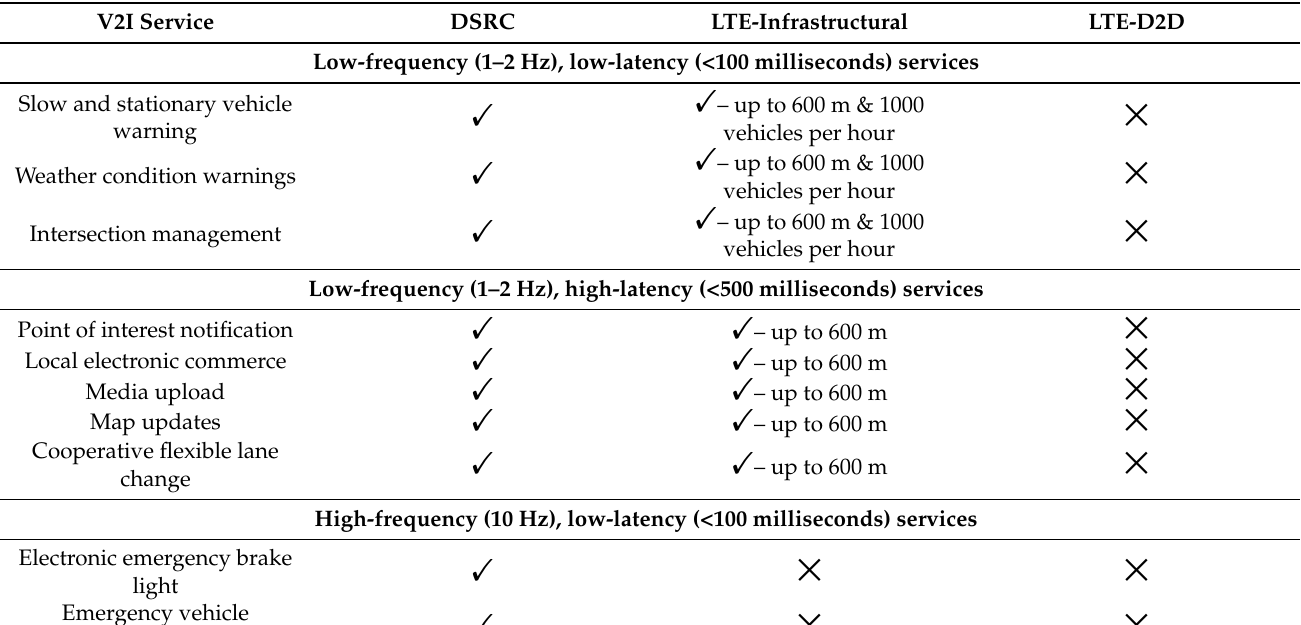
Table 5. Networking and connectivity requirements of the most popular V2I services and their fulfillment by the investigated communication technologies in the context of the selected urban scenario. Adapted and updated from